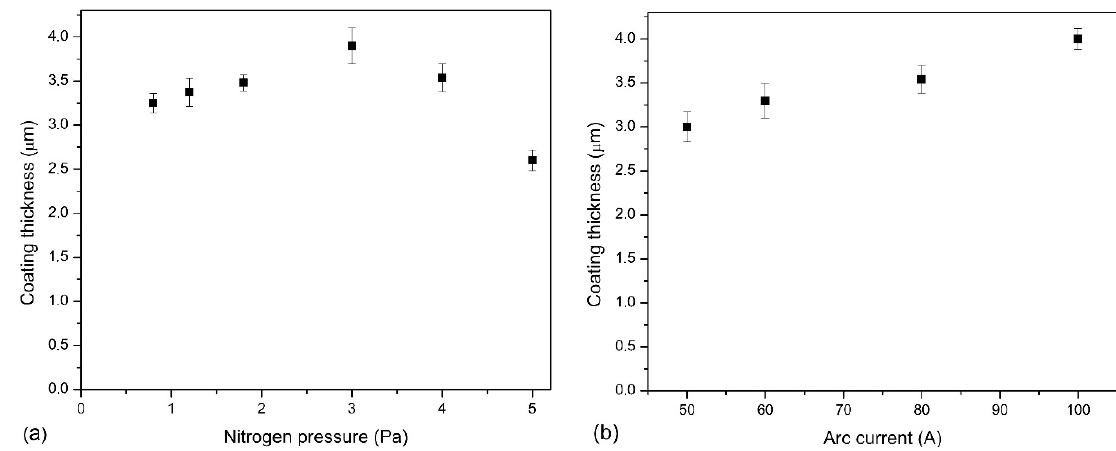
Figure 1. Thickness of AlCrN coatings formed at: ( a ) various nitrogen pressure, ( b ) various arc current.